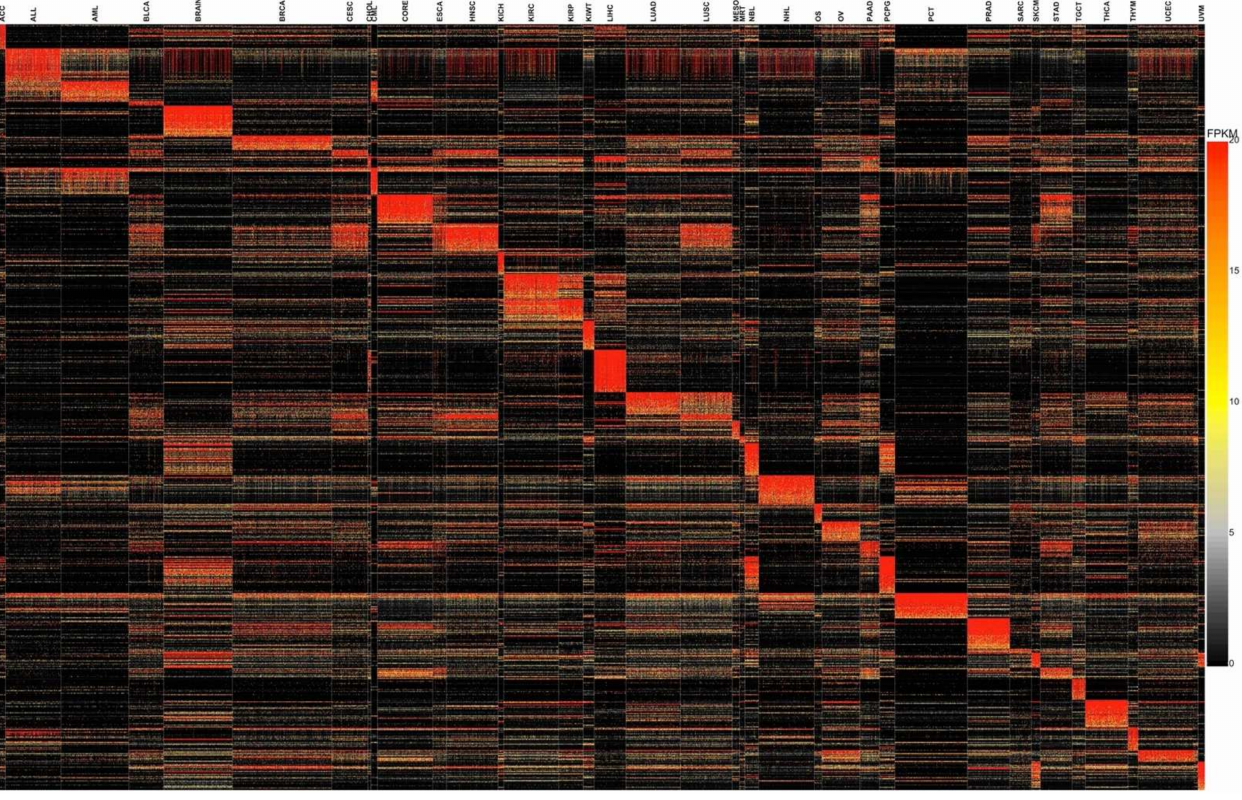
Figure 5. Cancer tissue-of-origin specific gene signatures. Supervised hierarchical clustering to show gene expression signatures associated with different cancer